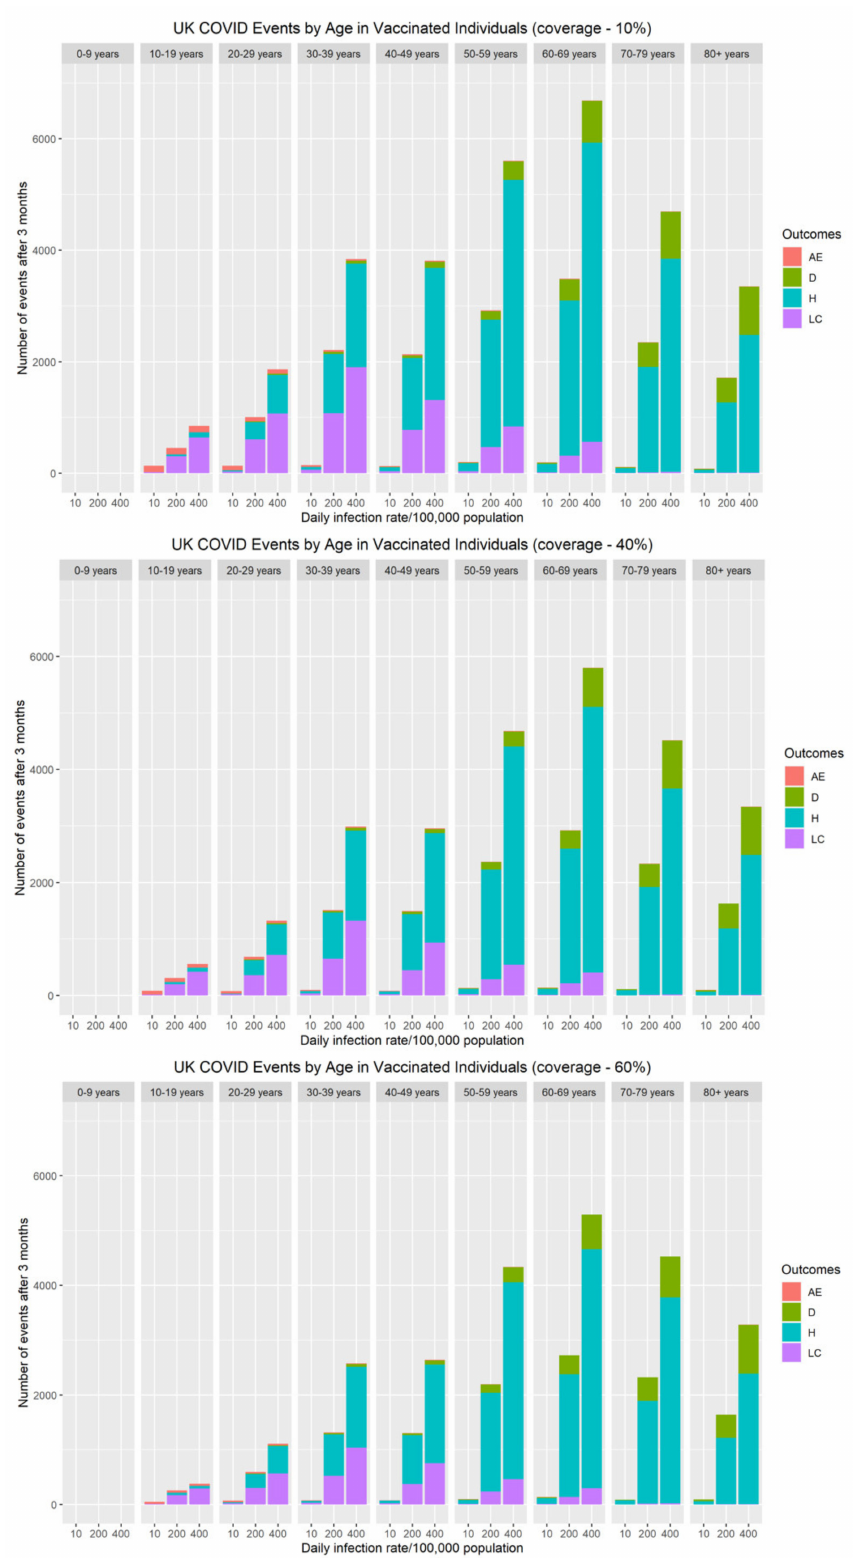
Figure 4. The impact of vaccine coverage and infection rates on the total number of adverse events (myocarditis/pericarditis), hospitalisations, long COVID and deaths after three months by age in vaccinated individuals in the